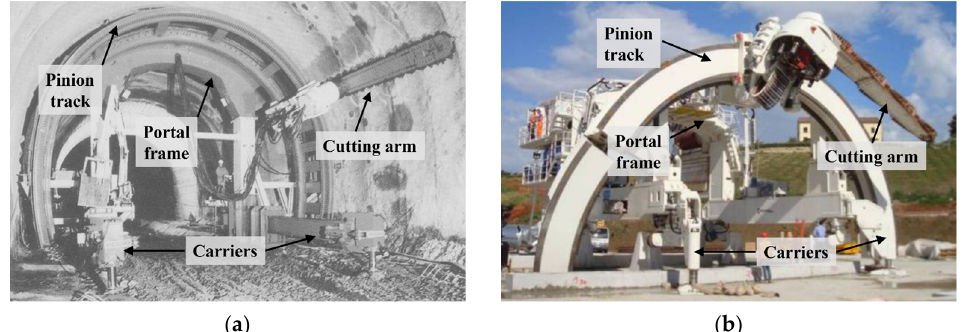
Figure 1. Pre-cutting machine: ( a ) in a double track railway tunnel (Reproduced with permission from Ref. [1]. 1991. E. van Walsum); ( b ) for enlargement (Reproduced with permission from Ref. [4]. 2014. Lunardi et al.).